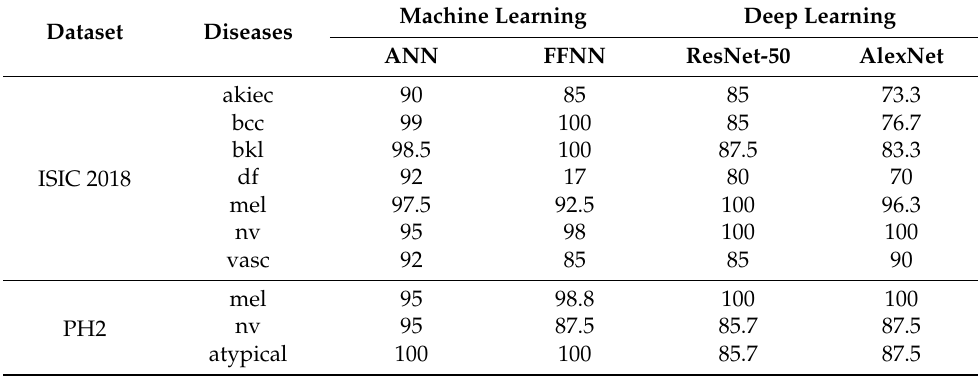
Table 7. The accuracy reached by each system in the diagnosis at the level of each